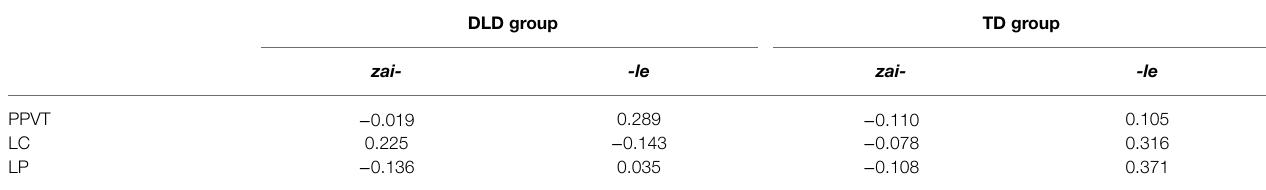
TABLE 7 | The result of correlation analysis (r).